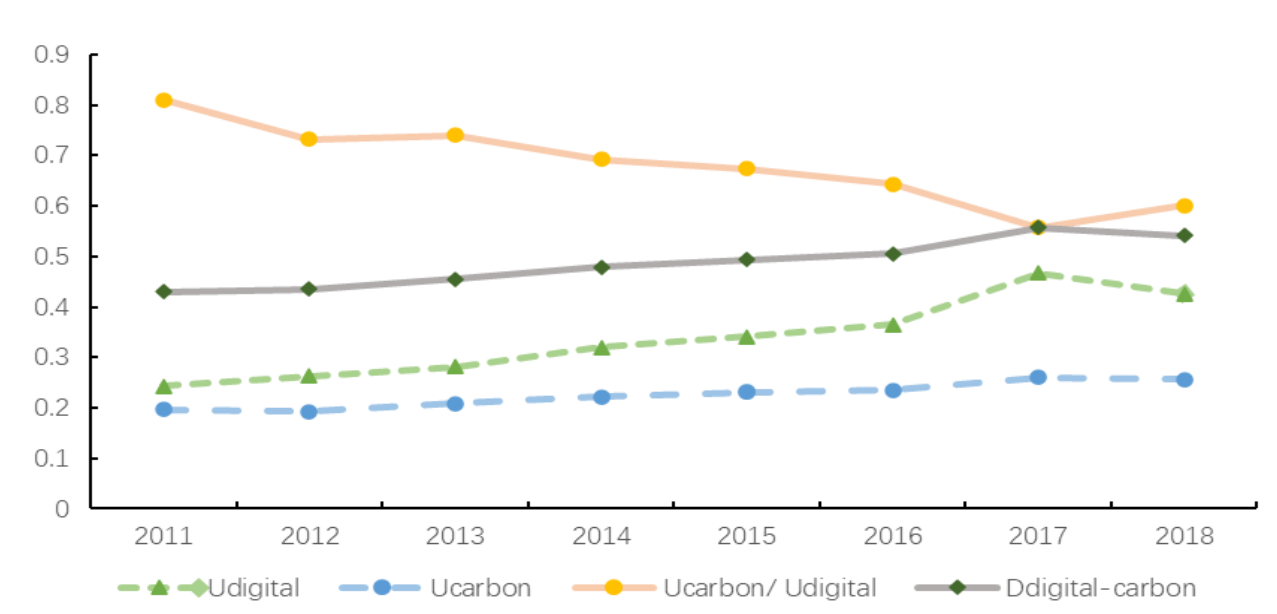
Figure 2. Status and trend of the coupling and coordination between digital economy development and carbon emissions reduction in